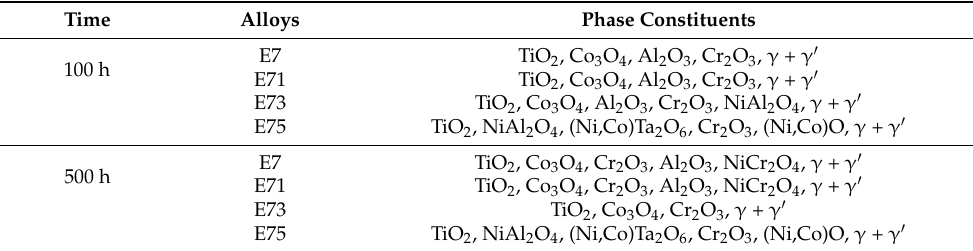
Figure 5. XRD patterns of samples exposed for 500 h at 1000 °C. Table 2. XRD results of the E7, E71, E73 and E75 alloys after isothermal oxidation at 1000 °C.